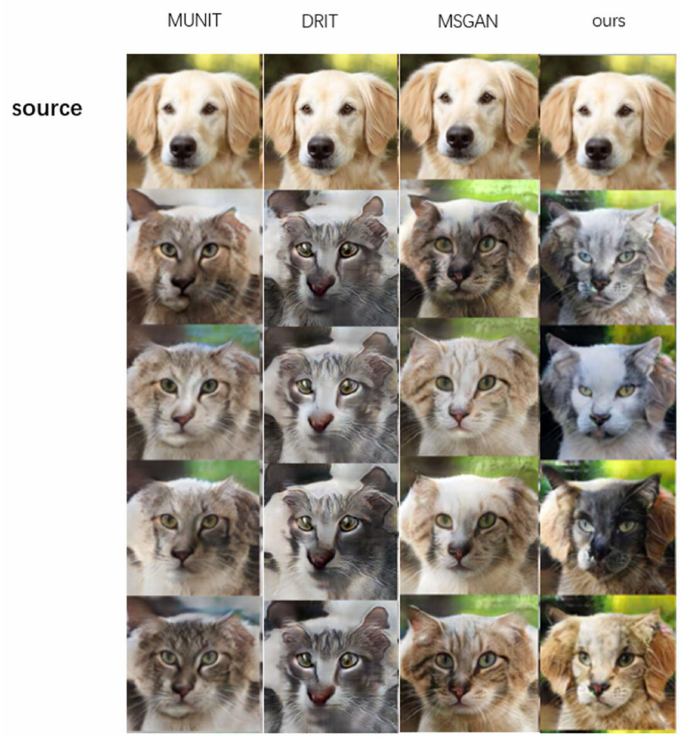
Figure 8. Using random noise to guide generation of images in AFHQ.